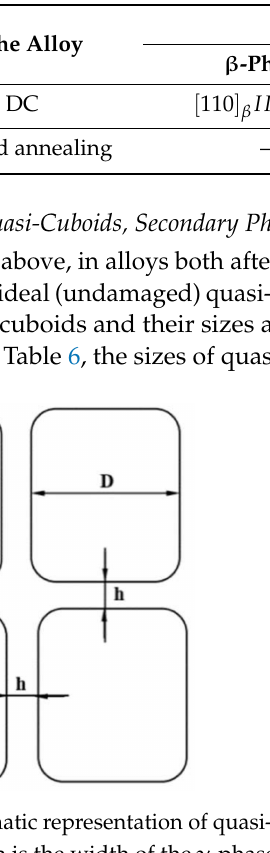
Table 5. Orientation ratios between the crystal lattice of the γ (cid:48) -phase and the crystal lattices of the secondary phases in various states of the alloy.